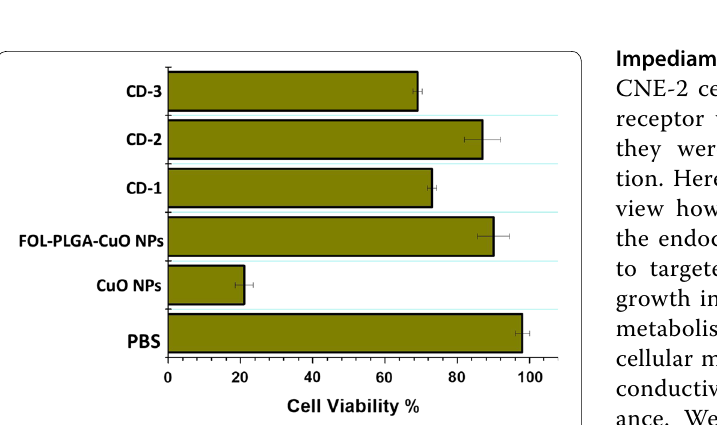
Fig. 6 Cytotoxicity of PBS, CuO NPs, FOL‑PLGA‑CuO NPs, CD‑1, CD‑2 & CD‑3. The cytotoxicity of CD‑3 is quite reduced